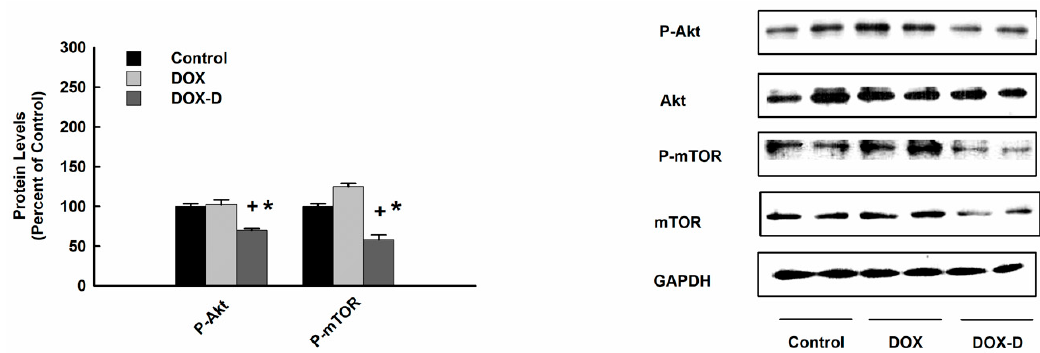
Figure 10. Effect of DOX and DOX-Vit D on Akt and mTOR signaling pathway. MG63 cells were treated for 24 h with 10 µM DOX and DOX-Vit D. Thereafter, total and phosphorylated Akt and mTOR protein expression levels were determined by Western blot analysis and detected using the enhanced chemiluminescence method. The intensity of protein bands was normalized to the signals obtained for GAPDH protein and quantified using ImageJ ® . The results are presented as the mean ± SEM ( n = 6). + p < 0.05 compared to control. * p < 0.05 compared to DOX.